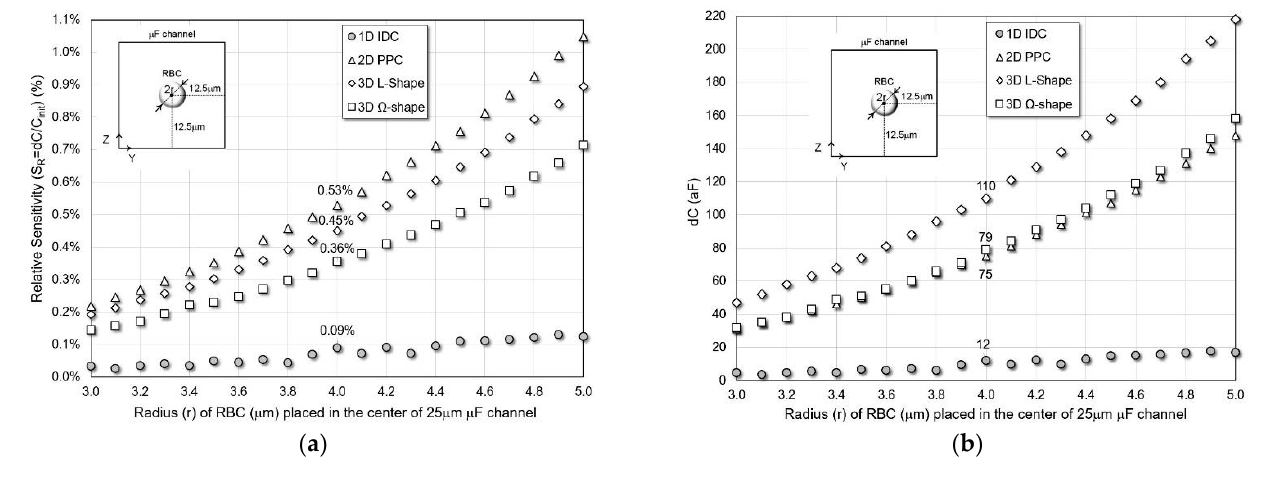
Figure 4. ( a ) Relative sensitivity and ( b ) capacitance change of the sensors for varying size of RBC cells placed in the center of a 25 μm microfluidic channel.